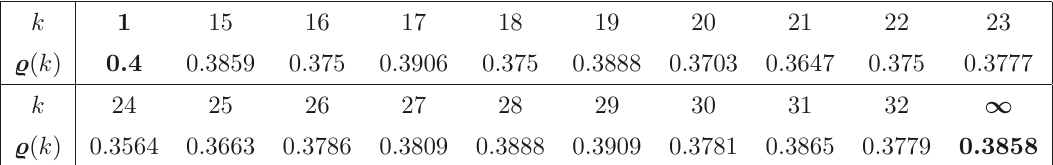
Table 2 . Values of the ratio ̺ ( k ) (up to four digits) for various values of the rank k k = 1 and the asymptotic value for k =